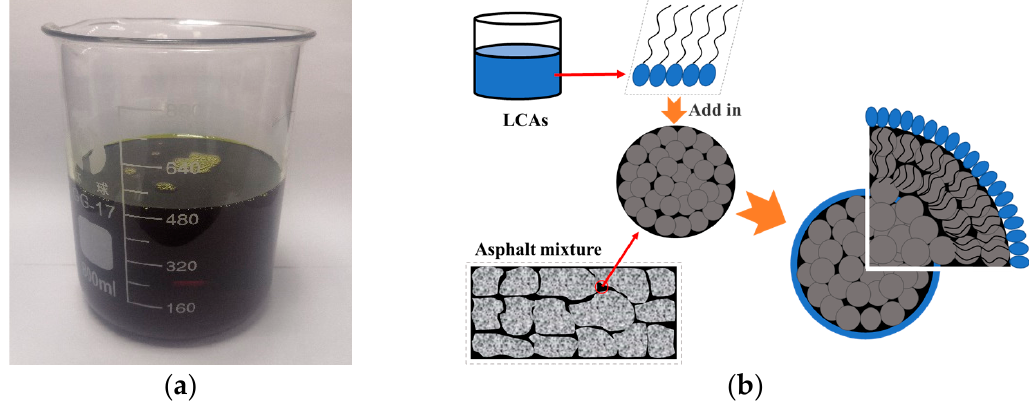
Figure 1. LCAs and their modification process in asphalt binder. ( a ) LCAs; ( b ) LCAs’ mechanism of action.